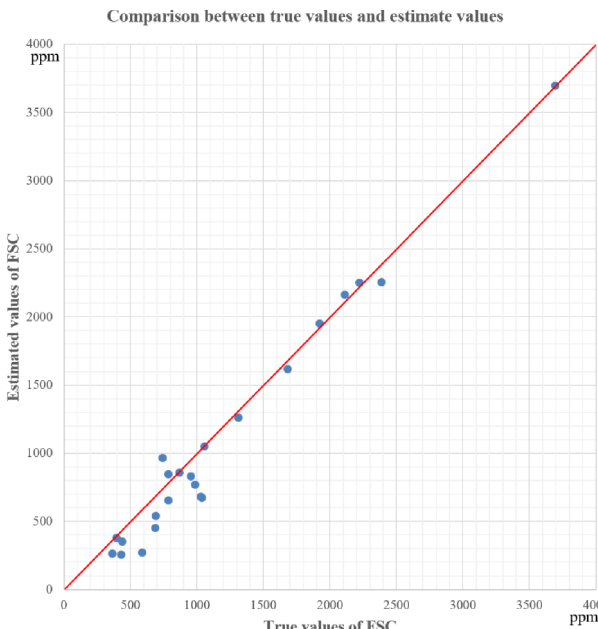
Figure 6. Comparison between the true values of FSC ( x axis) against the estimated values of FSC ( y axis) of 23